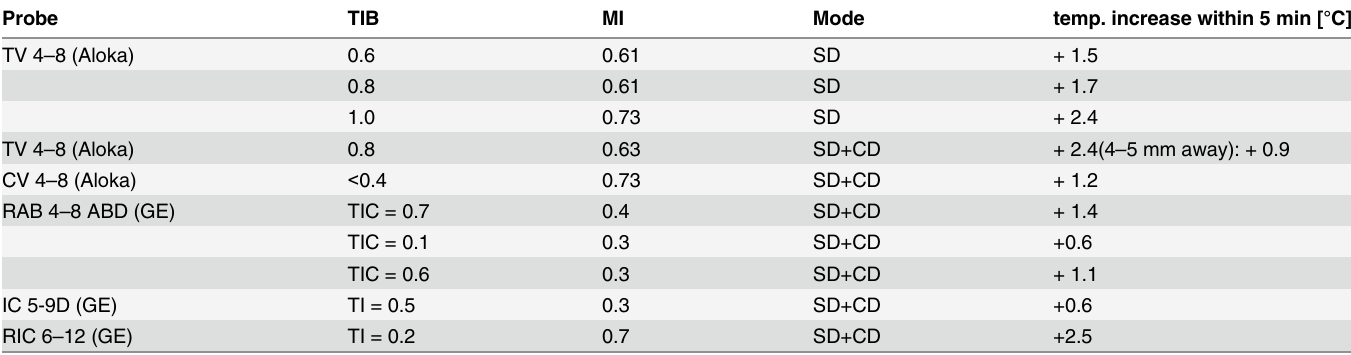
Table 3. Surface heating of probes within 5 minutes of spectral- Doppler and color Doppler emission.